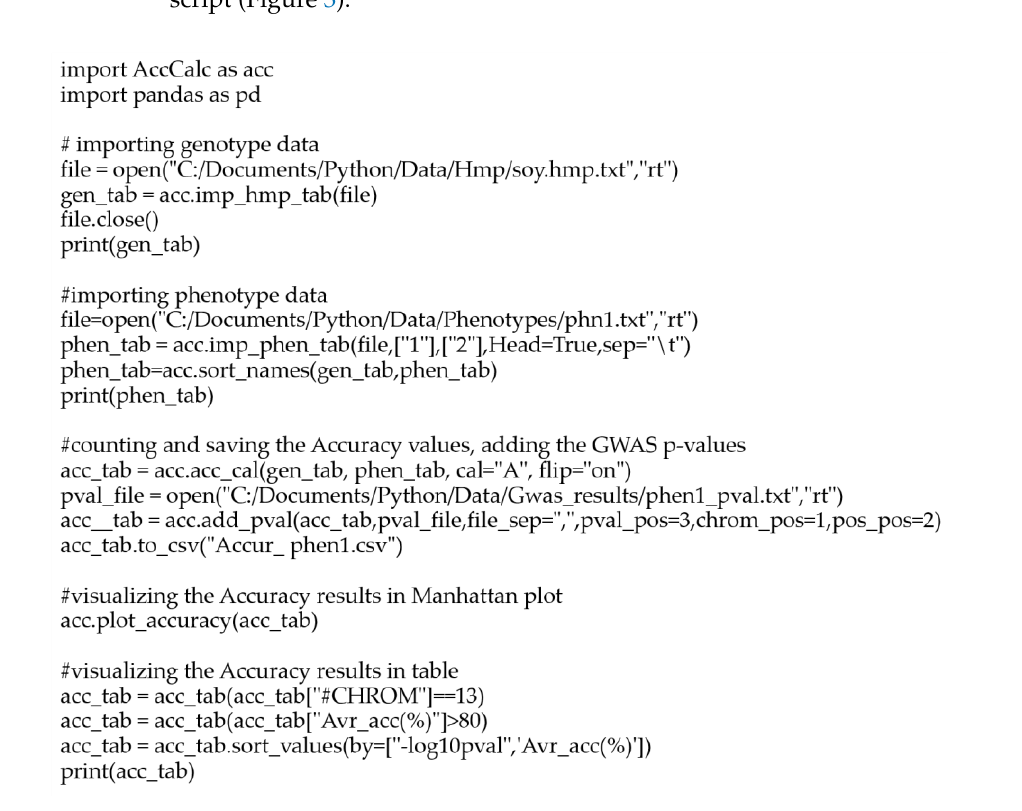
Figure 3. Example of the AccuCalc script. The AccuCalc script section describes the accuracy calculation and accentuation of the Manhattan plot with average accuracy for the case study of the flower color-associated region on chromosome 13. The option to filter based on average accuracy values >80% is